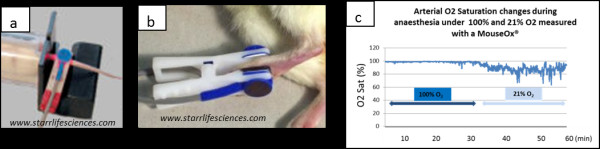
 Images displaying the clip sensors used by the pulse oximeter systems. (a) In the base of the mouse or (b) in the centre of the foot in rat. The MouseOx® murine pulse oximeter system from Starr Life Sciences® Corp. (Oakmont, PA, USA) provides measurements of O2 saturation, pulse rate, respiration and pulse and breathe distension. (c) Profile of arterial O2 saturation measurement in rat during MRI acquisitions at 100% and 21% O2 during inhalation anaesthesia with isoflurane.